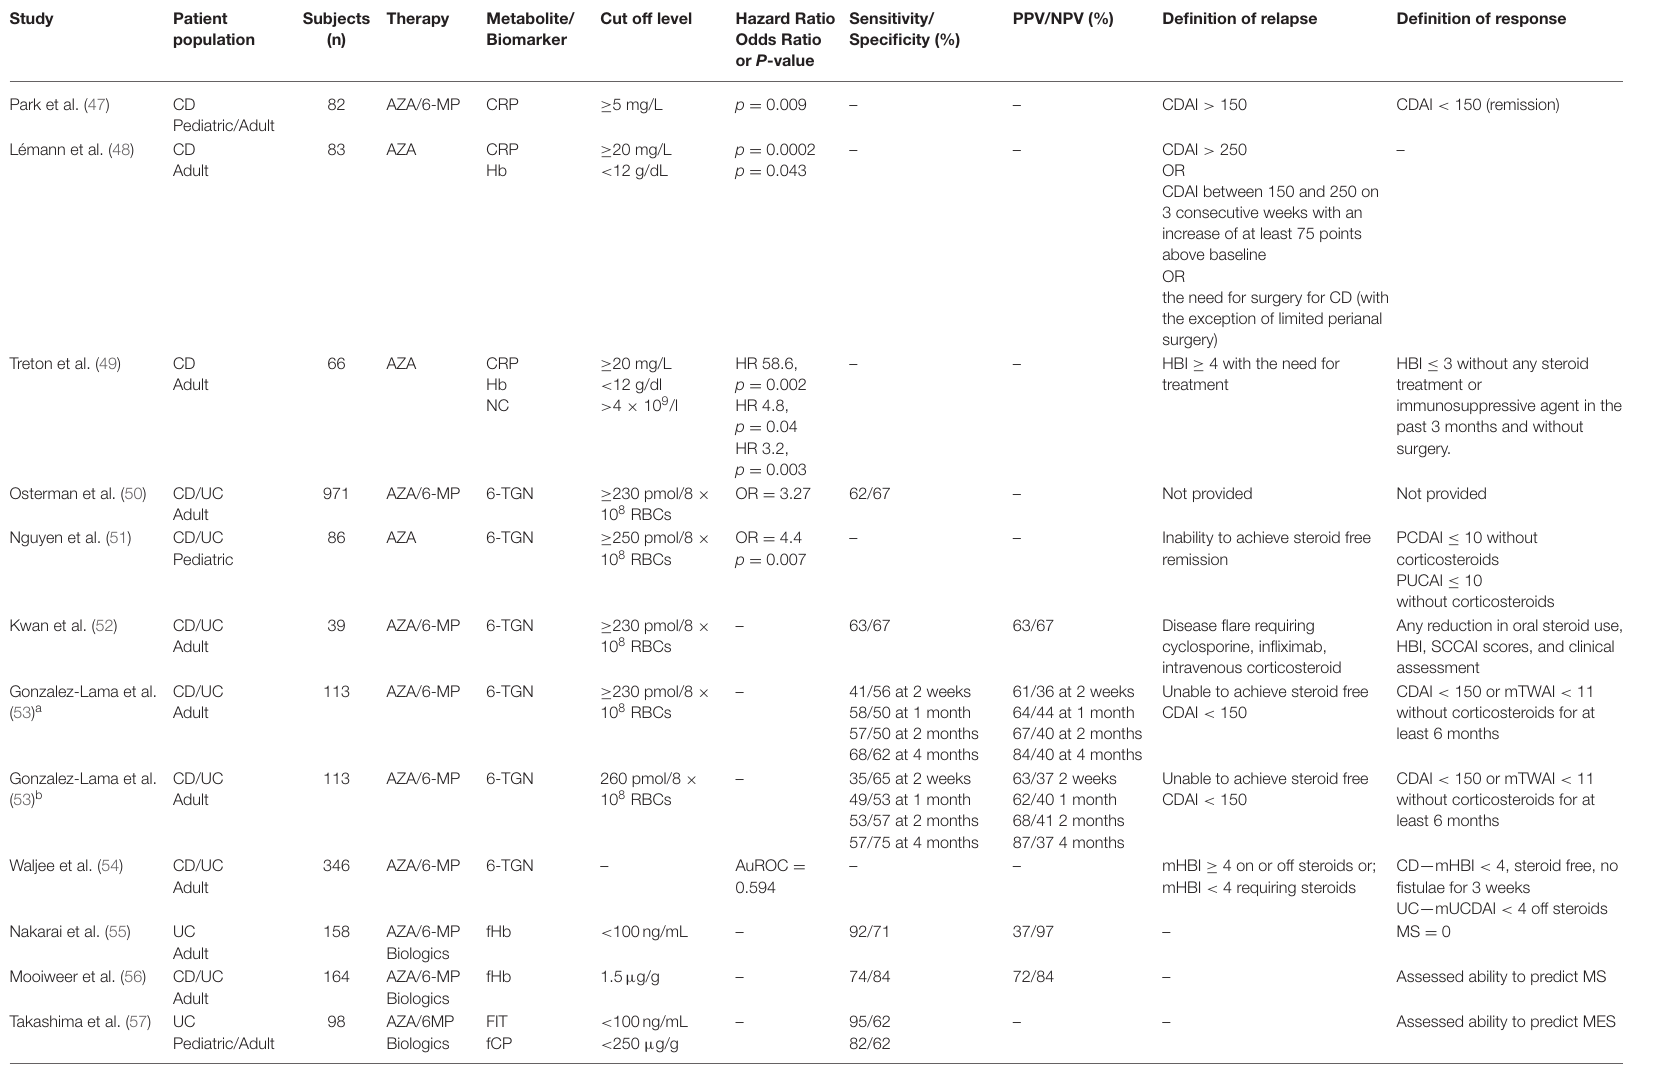
TABLE 1 | Studies assessing the value of biomarkers in predicting response to thiopurine treatment in